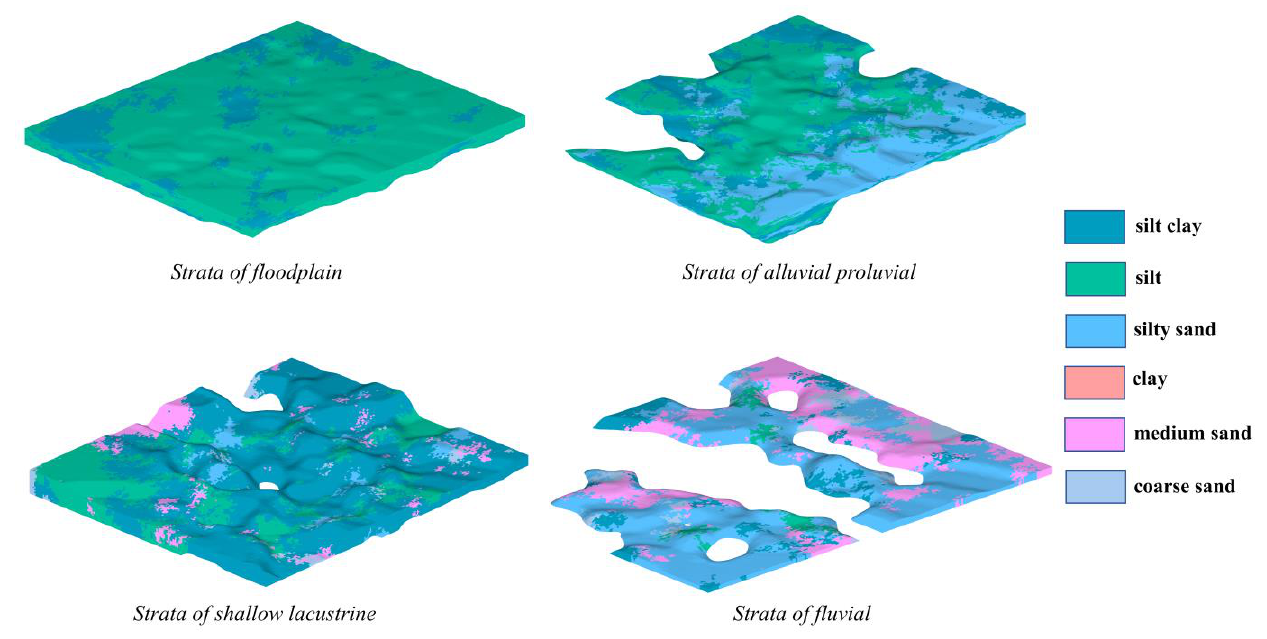
Figure 10. Stratigraphic lithology model of Quaternary loose sedimentary strata in the citizen center based on layered simulation. Vertical exaggeration = 5×.